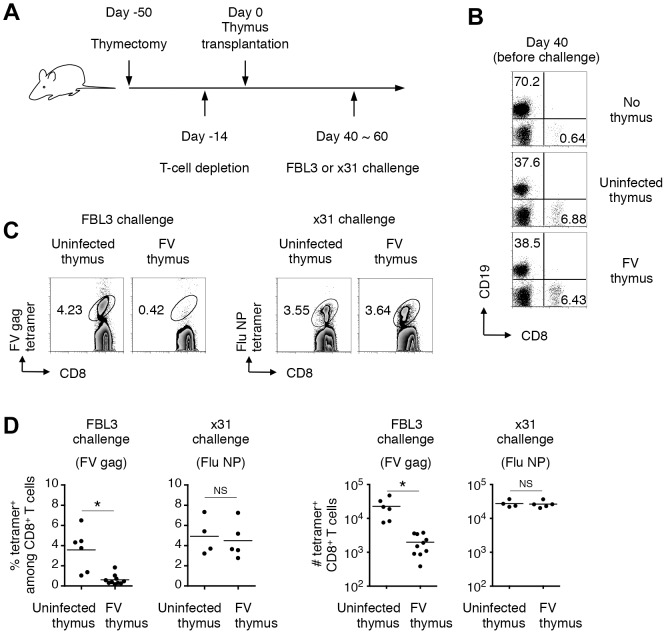
Infection of thymus with FV leads to clonal deletion of FV-specific thymocytes.(A) To make a T cell-free microenvironment in B6AF1 mice, day 5 neonatal pups were thymectomized, and 5 weeks later were injected intraperitoneally with depleting Abs for both CD4 and CD8. Two weeks later, a thymic lobe from either FV-infected (2–3 weeks post infection) or age-matched uninfected mice was grafted under the kidney capsule. (B) At day 40 after transplantation, splenocytes were isolated and stained with the indicated Abs. Shown are representative staining patterns for CD8 and CD19. (C) Six weeks after transplantation, when peripheral CD8 T cells were reconstituted, mice were challenged with either FV-antigen bearing FBL3 tumor cells or influenza virus ×31. Splenocytes were isolated at 10–14 days post challenge, and stained with the indicated Abs and either F-MuLV gag75–83/Db or Flu NP366–374/Db tetramer. Shown are representative staining patterns for CD8 and each tetramer among CD8+ T cells. (D) Shown are frequencies of tetramer+ cells among CD8+ T cells (left panels), and actual numbers of tetramer+ CD8+ T cells (right panels). Averages of % and actual numbers of tetramer+ cells were compared between uninfected and FV-infected groups by two-tailed Welch's t-test, as variances in both cases were not regarded as equal. *, p<0.021; NS, not significant.